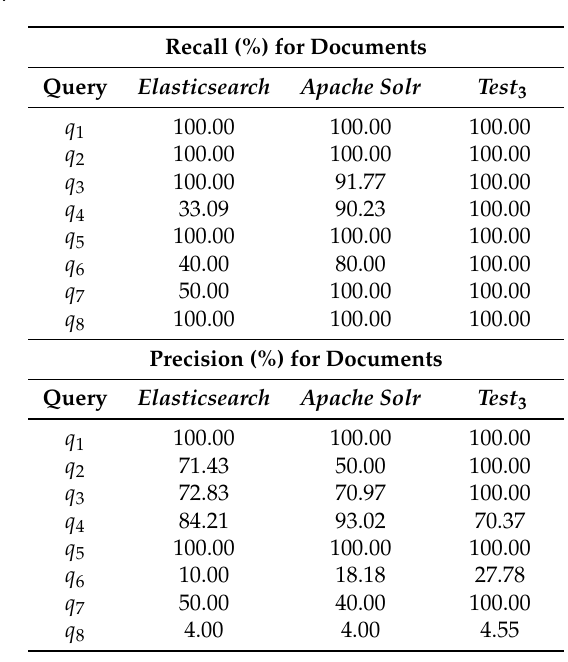
Table 4. Recall comparison of Test 3 with the baselines obtained by means of Elasticsearch and Apache Solr (for